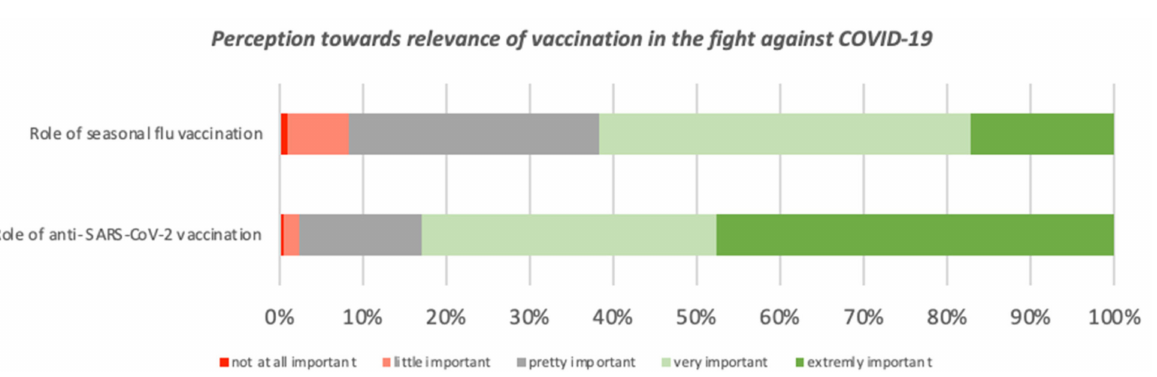
CoV-2 vaccination by 48% ( n = 820) and 35% ( n = 609) (Figure 4).